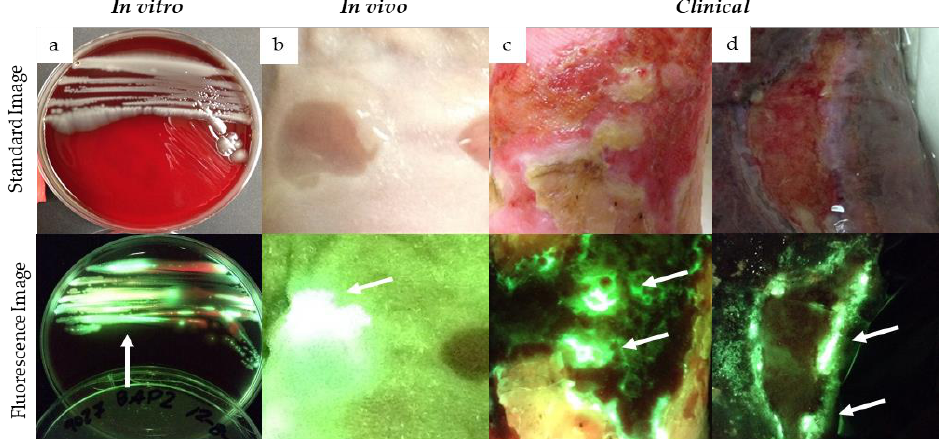
Figure 1. Detection of cyan fluorescence in preclinical and clinical studies using fluorescence imaging. Standard (top panel) and fluorescence (bottom panel) images were captured of preclinical and clinical cases of cyan fluorescence from Pseudomonas aeruginosa (PA). Cyan fluorescence was detected 24 h after inoculating blood agar plates with PA ( a ), and 24 h after NCr mouse wounds were inoculated with PA ( b ). Cyan fluorescence has also been observed from chronic wounds positive for PA ( c , d ), confirmed by microbiological analysis (clinicaltrials.gov (accessed on 1 February 2021): NCT03540004). White arrows denote regions of cyan fluorescence.